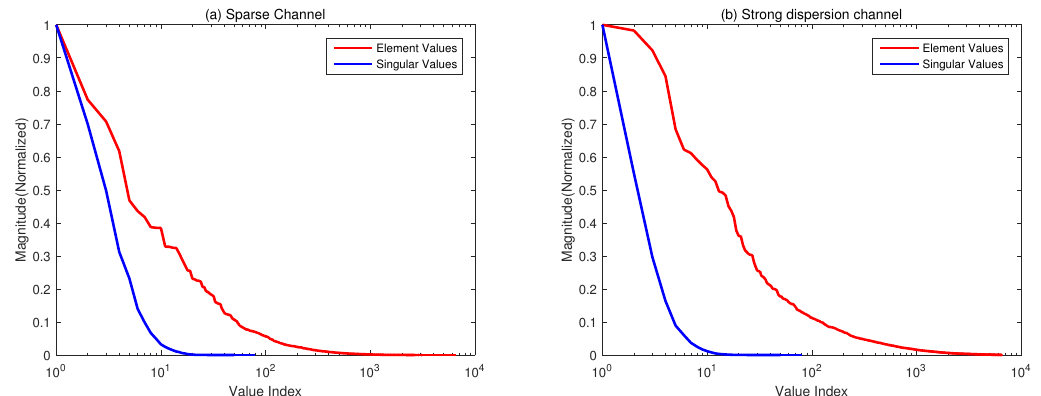
Figure 2. Comparison between the matrix values (magnitude) and singular values of DDSM. ( a ) Sparse Case; ( b ) Dispersion Case.